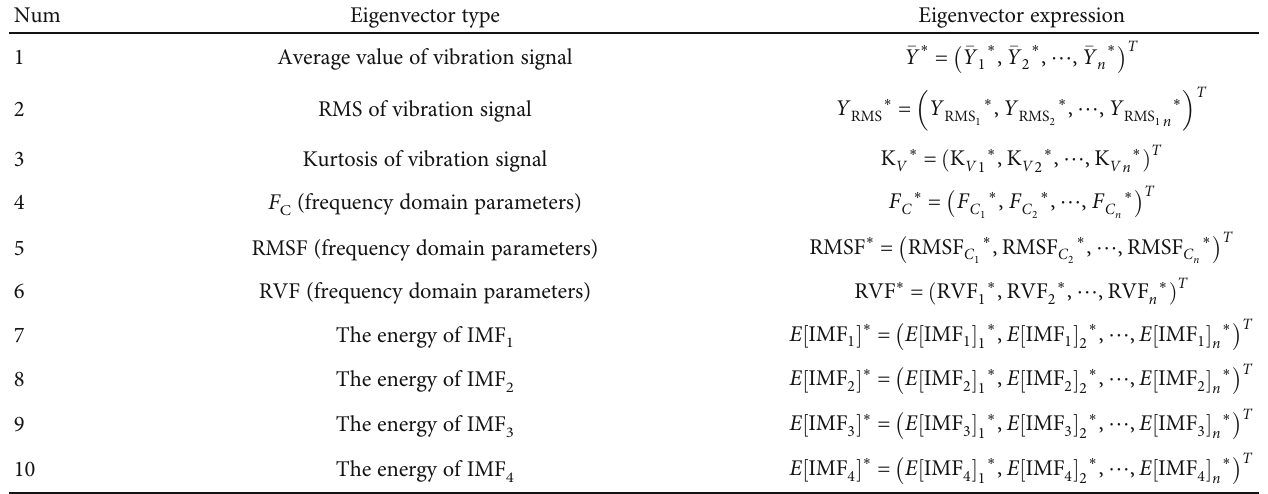
Table 1: Feature vector table of roll vibration signal for fl exible material R2R system.